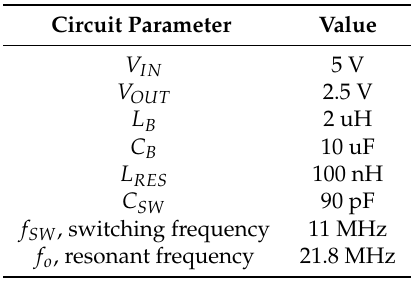
Table 1. Circuit